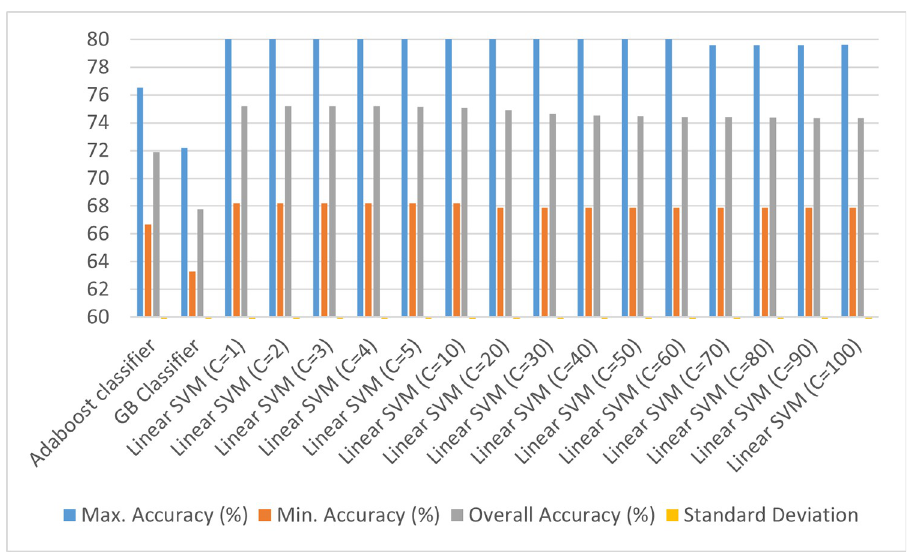
Fig 5. Classification results using power transformation on the numerical predictors and clipping the lowest and highest quantiles of data.